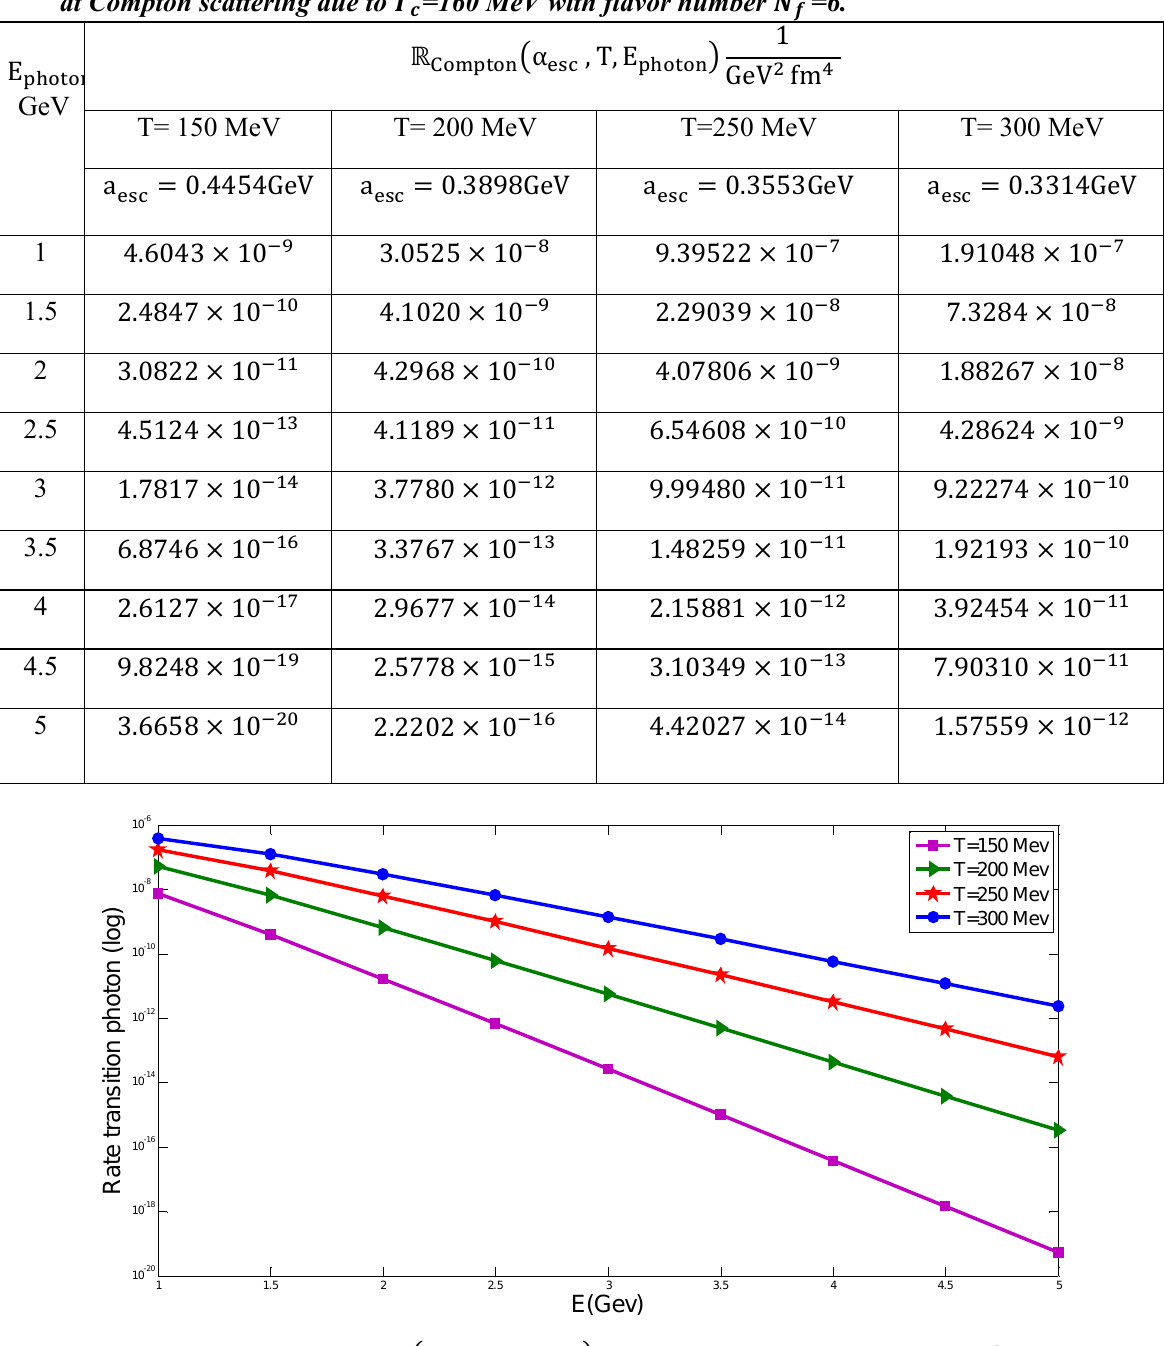
(cid:3435)(cid:2235) , (cid:2176), (cid:2161) (cid:3439) as a function of (cid:2161) (cid:2159)(cid:2197)(cid:2195)(cid:2198)(cid:2202)(cid:2197)(cid:2196) (cid:2187)(cid:2201)(cid:2185) (cid:2198)(cid:2190)(cid:2197)(cid:2202) (cid:2785) = 160 (cid:2183)(cid:2196)(cid:2186)(cid:2176) (cid:2185) (cid:2786)